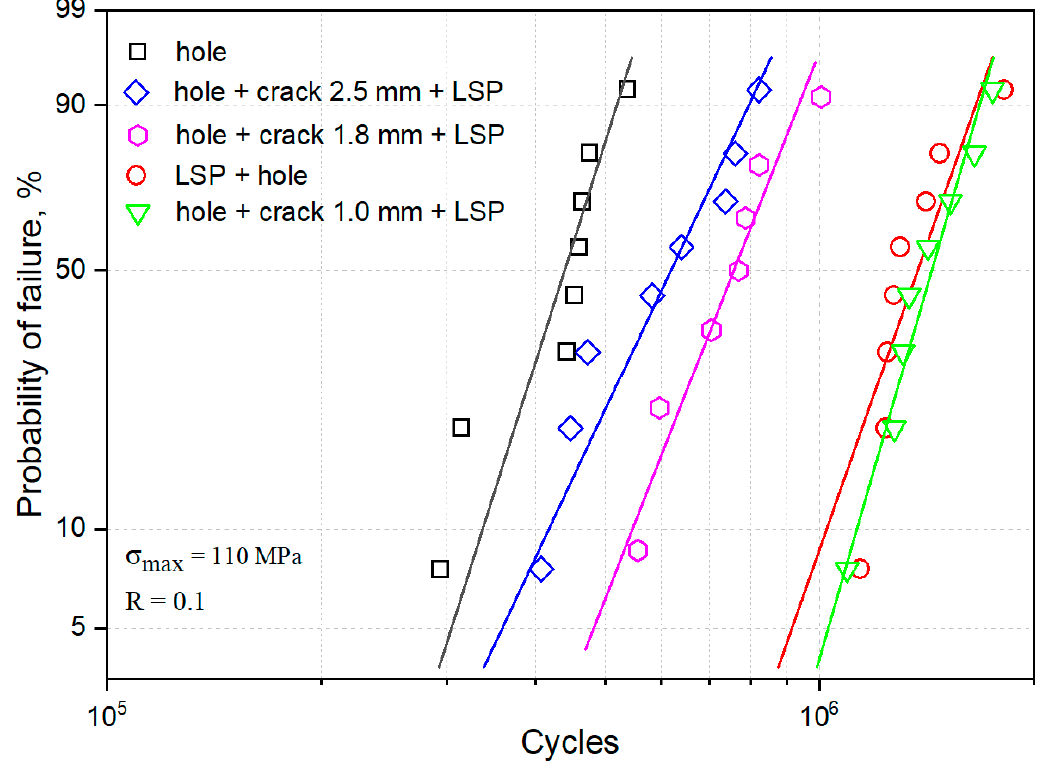
Figure 8. Weibull plot for all groups of tested specimens. Table 2. Parameters of Weibull distribution for each group.